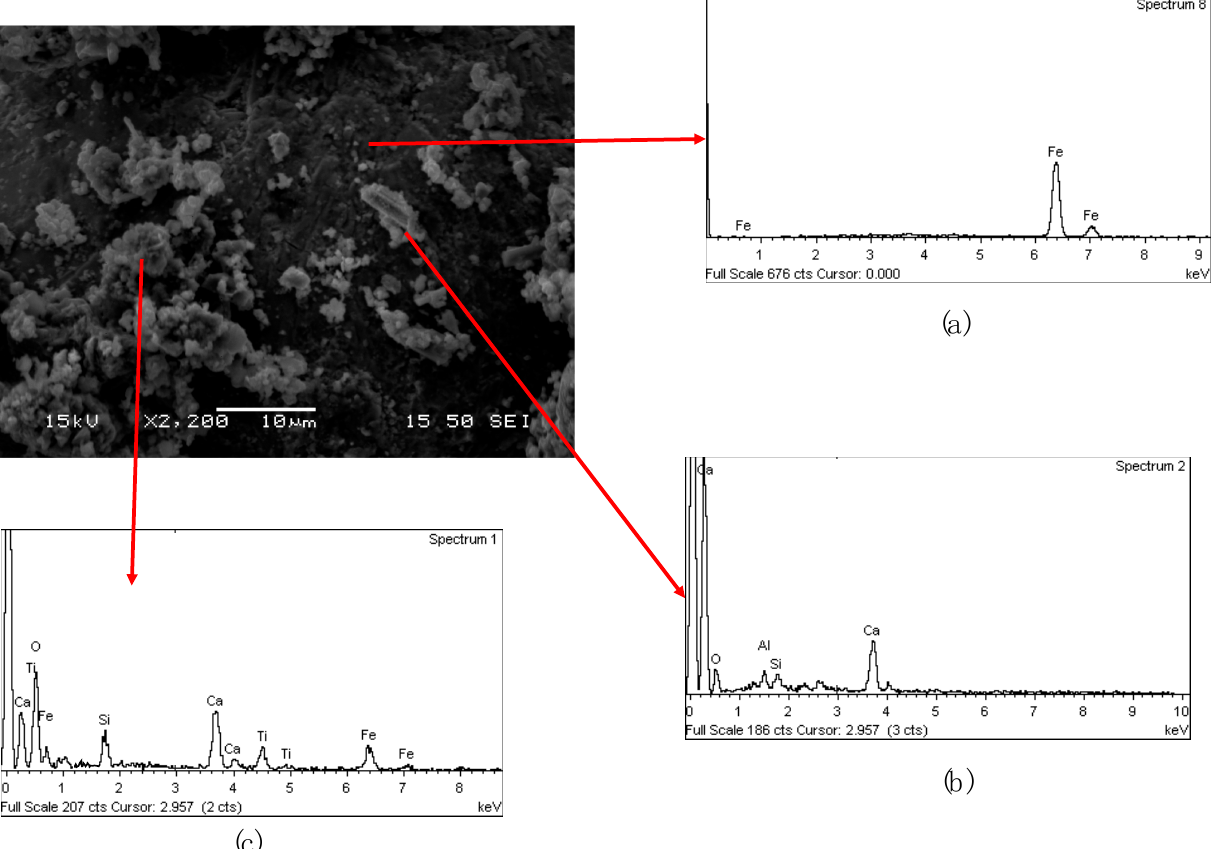
Figure 14. Secondary electron imaging mode SEM-EDS analysis of MAG I fraction: ( a ) melted metallic iron ( b ) calcium aluminium silicon oxide particles ( c ) particles composed of Si, Ca and Ti oxide mixture.